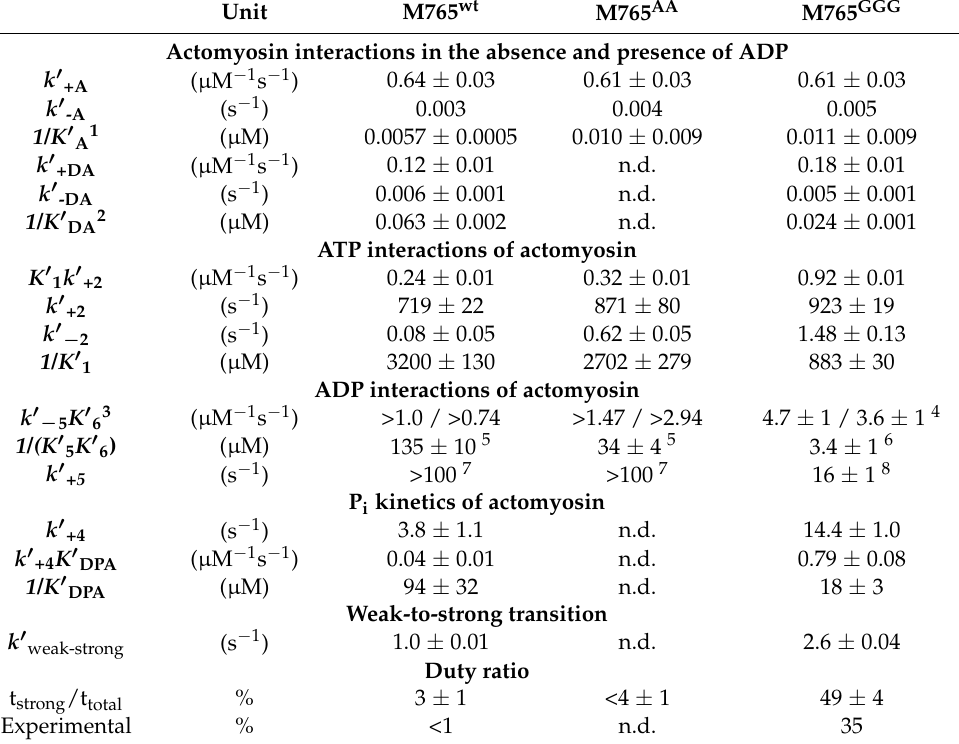
Table 4. Transient kinetic parameters and equilibrium constants in the presence of actin.